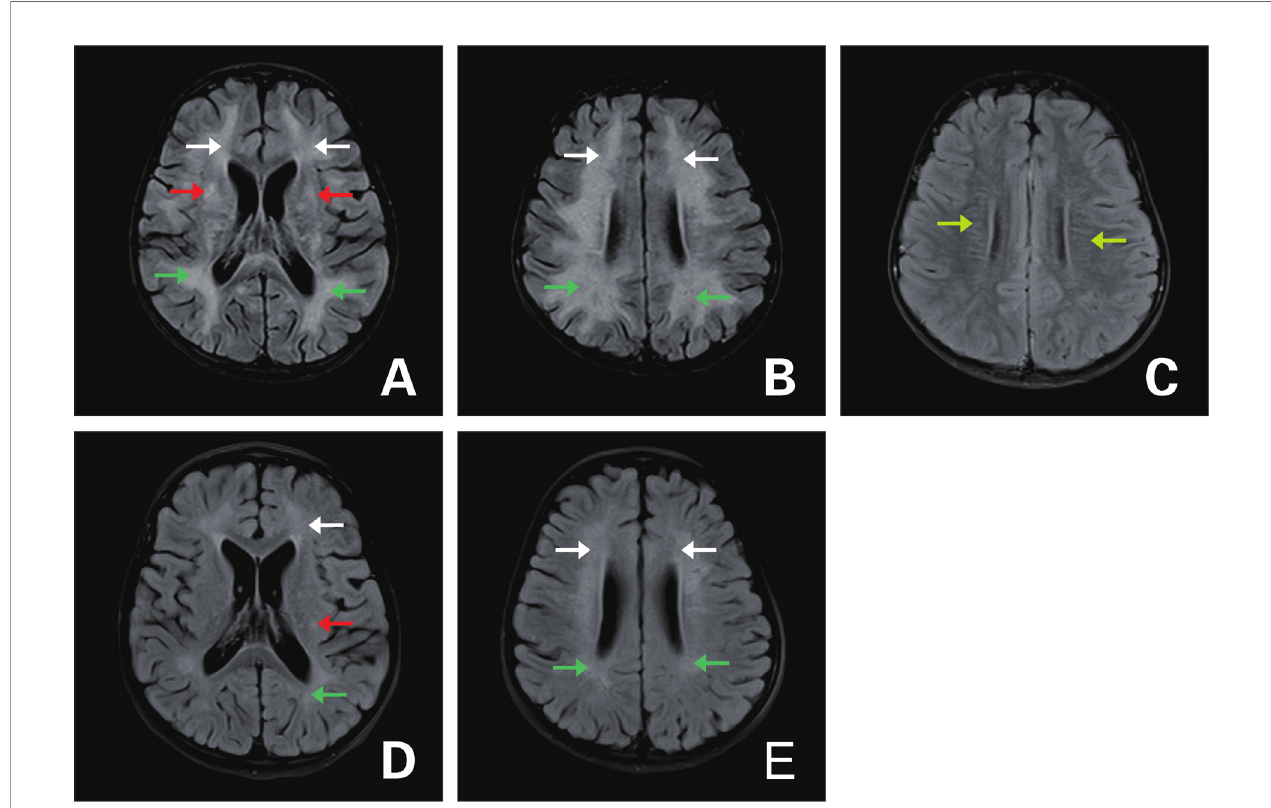
FIGURE 1 | Axial fl uid attenuation inversion recovery (FLAIR) MRI of the brain (A – C) upon admission and (D, E) 3 months later. (A, B) T2-hyperintense lesions in the white matter of bilateral cerebral hemispheres (white arrow: frontal lobe; green arrow: parietal lobe), bilateral basal ganglia (red arrow). (C) Periventricular radial linear enhancement (light green arrow). (D, E) Follow-up images of improved T2